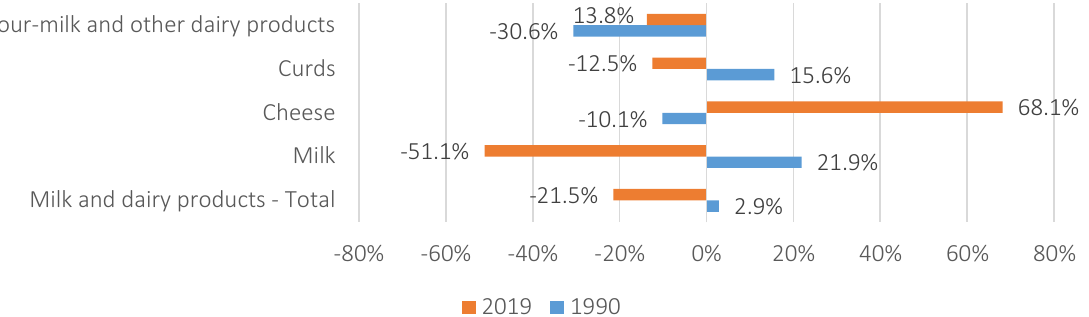
Figure 2. Comparison of recommended and real consumption of milk and dairy products in the Slovak Republic in 1990 and